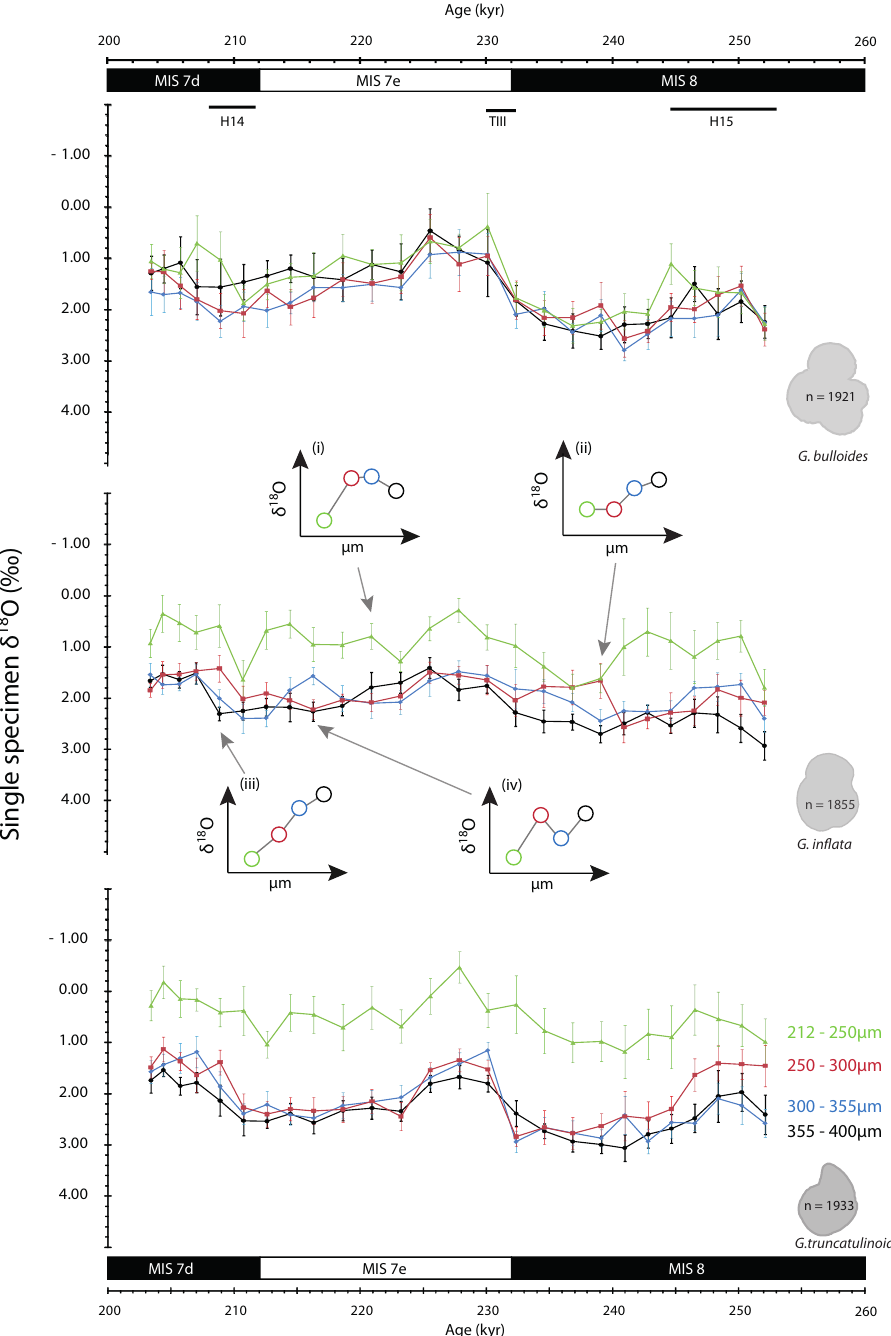
Figure 5. Mean oxygen isotope values with 95% confidence intervals. Mean δ 18 O values for (top panel) G. bulloides , (middle panel) G. inflata and (bottom panel) G. truncatulinoides ; colour denotes size fraction. Confidence intervals are based upon using the outlier-corrected single-specimen data to compute a t -based confidence interval ( n < 30) at the 95% level ( α = 0 . 05), assuming that the sample is normally distributed. Insets in the middle panel show the size versus oxygen isotope for (i) 220.9kyrBP reminiscent of the study of Ravelo and Fairbanks (1992): (ii) 239.1, (iii) 208.9 and (iv) 216.3kyrBP. A one-sample t test shows that (i) and (iv) do not have sufficient evidence to reject the null hypothesis ( H 0 ) that the means are different, whereas (ii) and (iii) have sufficient evidence to accept the alternative hypothesis ( H 1